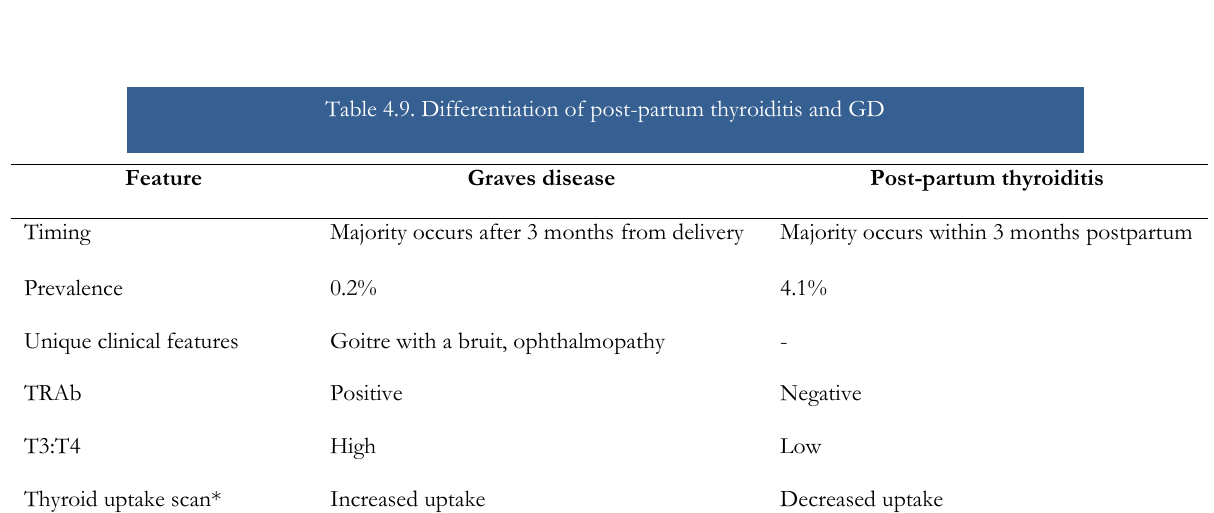
Figure 4.3. Clinical presentations of post-partum thyroiditis